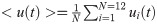
The schematic diagram of the way we calculate the minimal one-dimensional (1D) Winfree-loop length Lmin.(a) An artificial 1D periodic excitable ring containing 12 nodes is constructed. (b) The wave form on a 1D periodic excitable ring containing 12 nodes, which will be used as the initial condition for (a). When the wave form shown in (b) is applied, unidirectional wave propagation is formed along the pathway 1 → 2 → 3 → 4 → 5 → 6 → 7 → 8 → 9 → 10 → 11 → 12 → 1 to form 1D Winfree-loop in (a) (indicated by the outside black arrowed lines). As the peak of the excitable wave passes through node 1, the following operation is executed: Node 12 in (a) is discarded from the 1D excitable ring (i.e., discarding the connections between node 12 and other nodes, denoted by the two red short lines). Simultaneously, a connection between nodes 1 and 11 is added (denoted by the red long line). The operation is executed at t = 31.32. Then, a new shorter 1D Winfree-loop composed by 1 → 2 → 3 → 4 → 5 → 6 → 7 → 8 → 9 → 10 → 11 → 1 self-organizes to support the oscillation (indicated by the inside red arrowed lines). (c) Trajectory of <u(t)>=1N∑i=1N=12ui(t) as the above operation is executed successively at t1 = 31.32, t2 = 92.55, t3 = 150.87 and t4 = 211.68, respectively. As the fourth operation is executed at t4 = 211.68, < u(t) > damps to zero quickly, which indicates that the minimal 1D Winfree-loop length supporting self-sustained oscillation at diffusion coefficient D = 4.0 is found to be 9 (i.e., Lmin = 9 at D = 4.0). (d) (e) The DPAD pattern ((d)) and the space-time plot ((e)) corresponding to the minimal 1D Winfree-loop containing 9 excitable nodes.